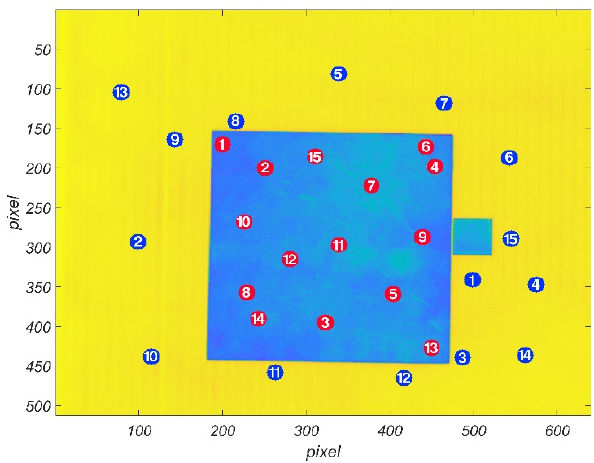
Figure 12. Randomly selected small circular measurement areas.